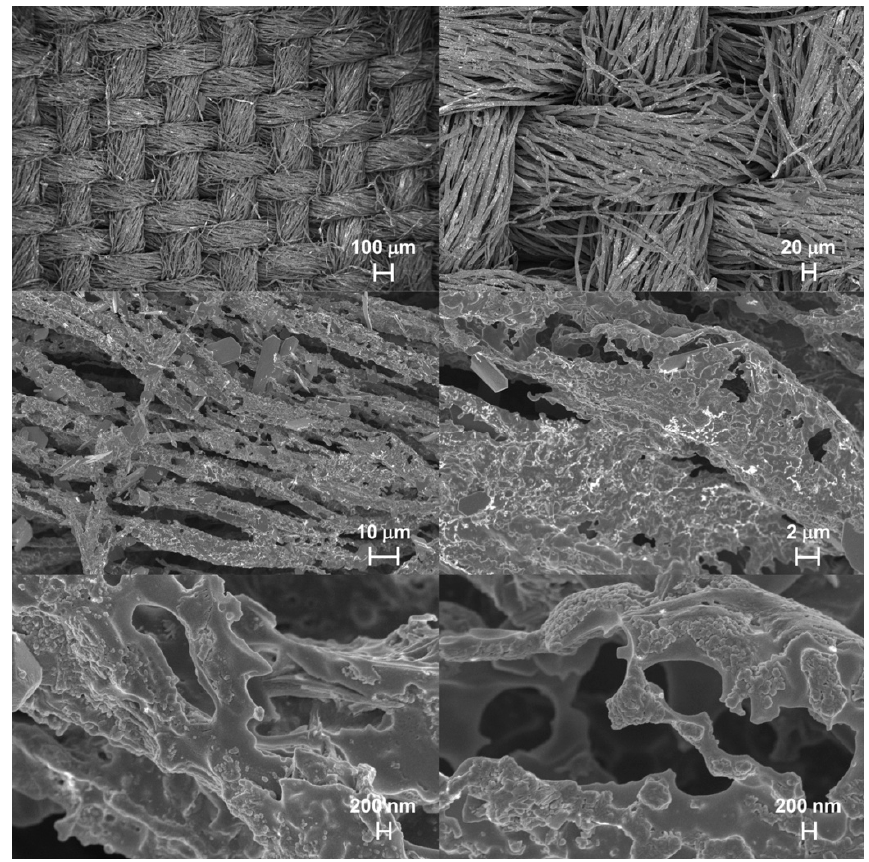
Figure 14. FE-SEM micrographs of COT/M–G 50 –C 50 residue after cone calorimetry tests.